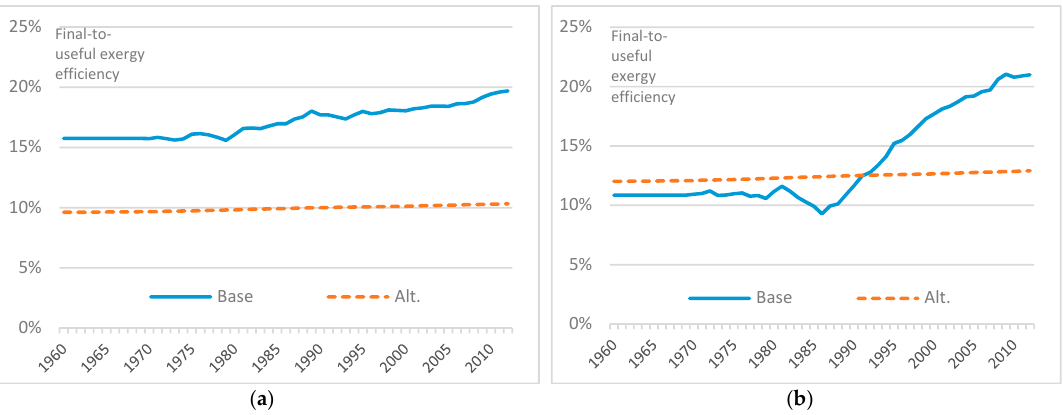
Figure 6. End-use exergy efficiency using base and alternative methods for ( a ) petrol road vehicles and ( b ) diesel road vehicles.